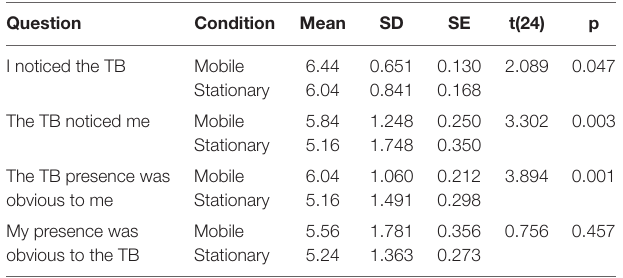
TaBle a7 | Results summary: + indicates higher mean rating in support of hypotheses, − indicates the hypotheses was not supported, * indicates statistical significance ( ρ < 0.05) and − * indicates contradiction to the hypotheses. Questionnaire